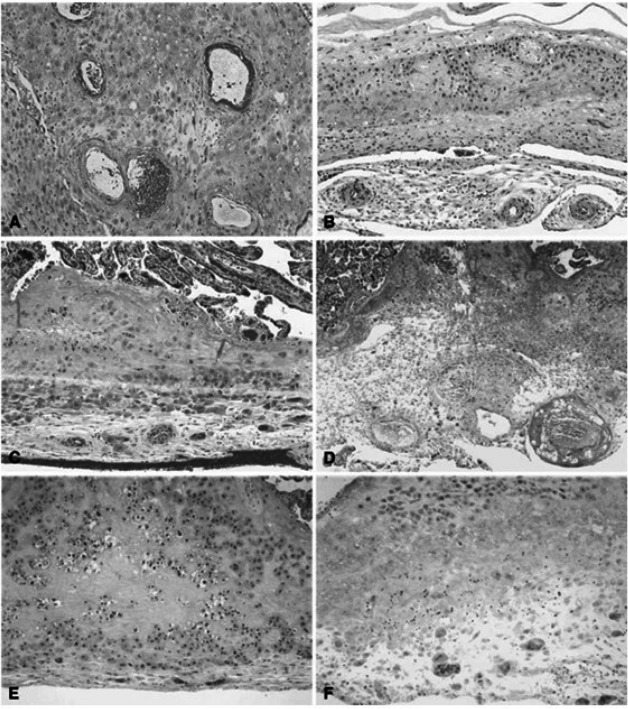
Histologic features of maternal vessels and implantation site reaction patterns.(A) Acute atherosis of maternal arterioles in the placental membranes: a cluster of decidual arterioles shows varying stages of fibrinoid necrosis. The vessel at the upper right shows full histologic expression with dark homogenous fibrinoid replacement of the vessel wall accompanied by occasional foamy macrophages ([original magnification is indicated for all panels] X 20). (B) Mural hypertrophy of decidual arterioles in the placental membranes: a cluster of arterioles shows medial hypertrophy with the vessel wall occupying greater than one third of total vessel diameter (X 10). (C) Muscularized basal plate arteries with accompanying implantation site abnormalities: maternal spiral arteries in the basal plate lack normal trophoblast remodeling and retain their pre-pregnancy muscular media. Clusters of immature intermediate trophoblast and increased placental giant cells are seen above and below the muscular arteries, respectively (X 10). (D) Acute atherosis of muscularized basal plate arteries with accompanying implantation site abnormalities: three cross sections of a basal plate artery are seen. The two on the left show persistence of the muscular media while the one on the right has undergone fibrinoid necrosis of the media with foamy macrophages (acute atherosis). Clusters of immature intermediate trophoblast are also seen overlying the arteries (X 4). (E) Immature intermediate trophoblast: clusters of abnormally small intermediate trophoblast with focal vacuolation are surrounded by an excessive amount of basal plate fibrin. Increased placental site giant cells are also seen at the lower margin (X 10). (F) Increased placental site giant cells: numerous multinucleate placental site giant cells, not usually seen in the delivered placenta, are scattered in loose decidual tissue which is devoid of normal intermediate trophoblast and fibrinoid (X 10). From Redline et al. (2004).